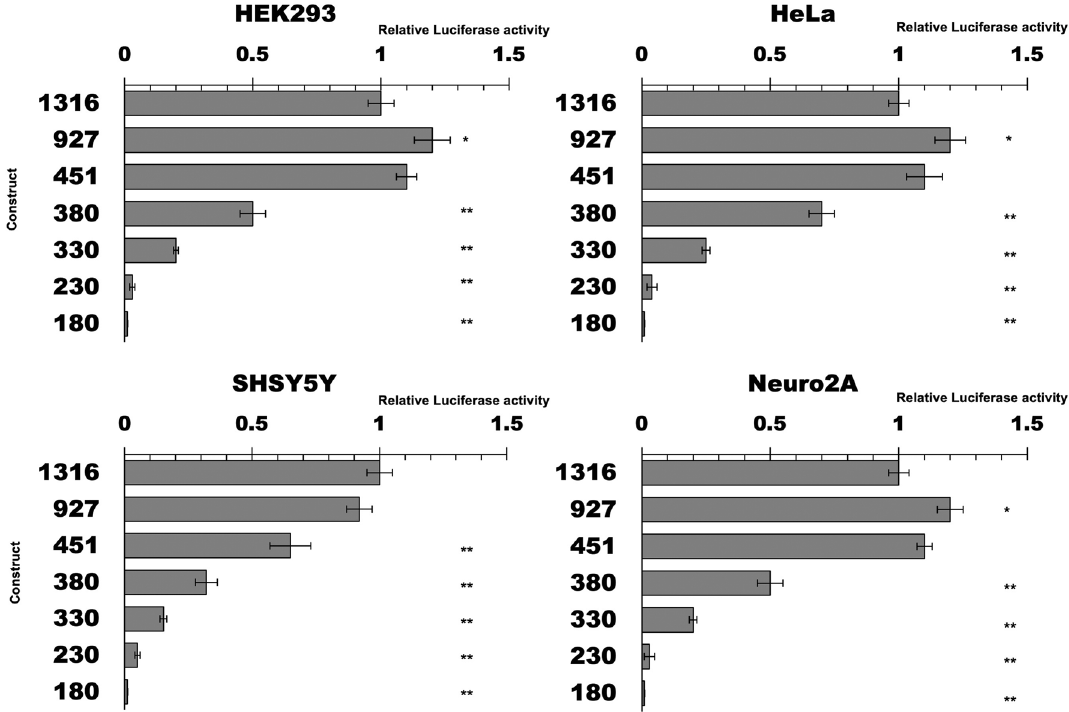
Figure 4. Deletion analysis of the human TARDBP promoter. Firefly luciferase activity of TARDBP promoter deletants in different cell lines (HEK293, HeLa, SH-SY5Y and Neuro2A) was measured in the cell lysate and values were normalized against Renilla. Activity of deletants is expressed as-fold against the cells transfected with the 1316 construct (= 1). Bars indicate the mean value of three independent assays. Error bars indicate standard deviation: *p < 0.05, and **p < 0.01 (One way ANOVA with Tukey test).